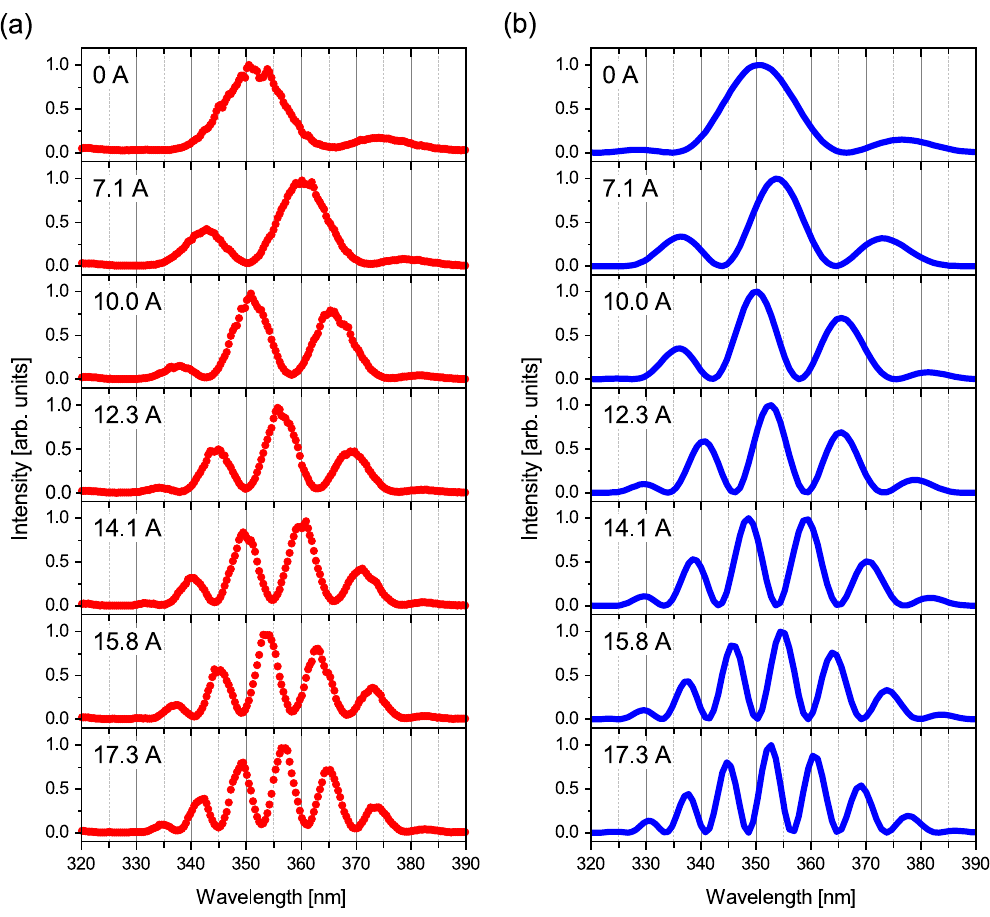
Figure 3. Spectra from the tandem undulator at various values of the phase shifter current. ( a ) Measured spectra. ( b ) Calculated spectra obtained by applying the Fourier transform to the double-pulsed 10-cycle sinusoidal wave packet which has the same shape used in the calculation of the autocorrelation